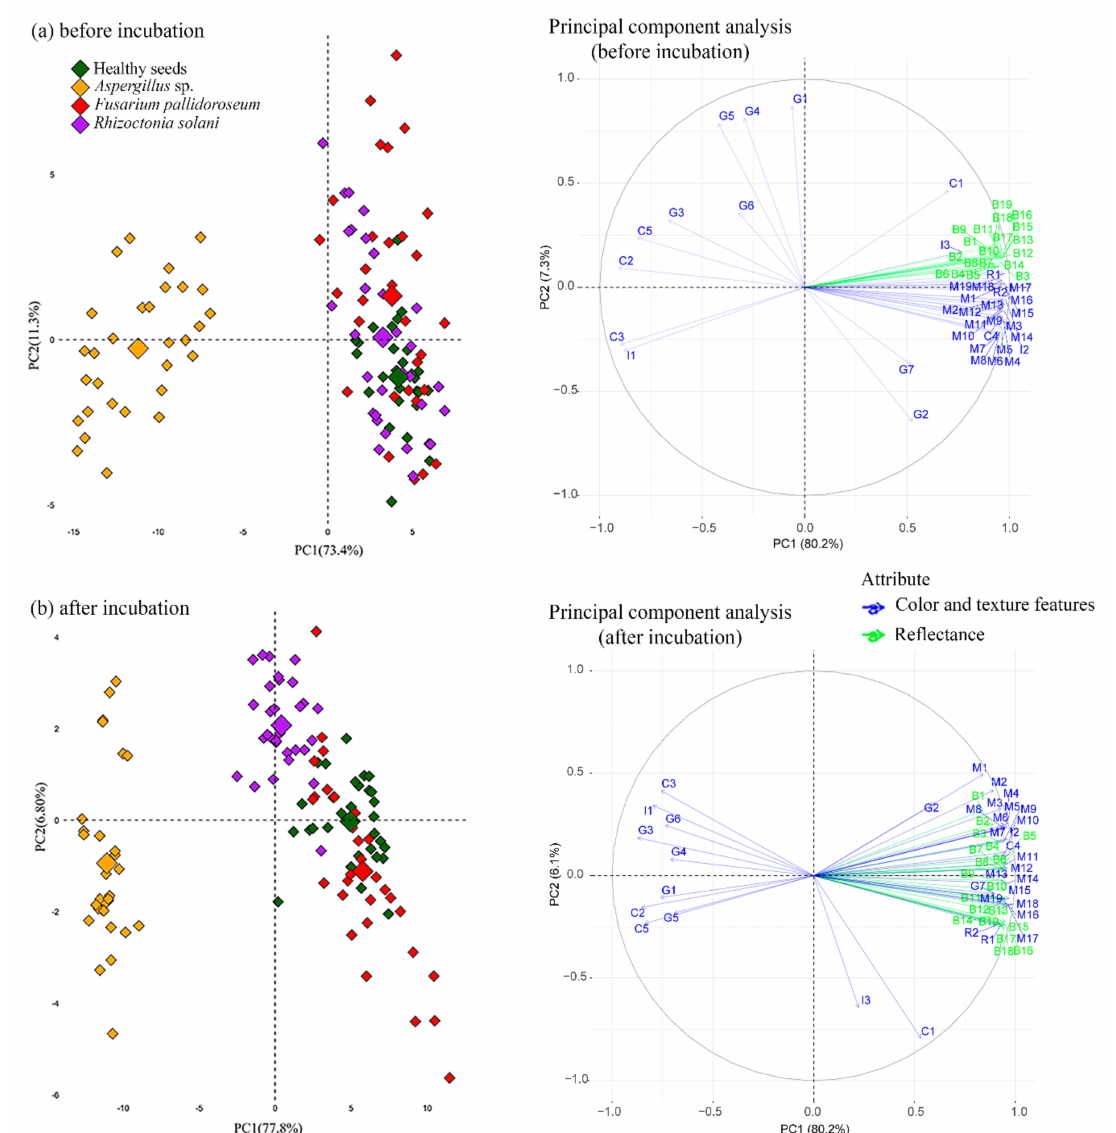
Figure 3. Biplots of principal component analysis for multispectral reflectance, color and texture features for classes of healthy seeds, Fusarium pallidoroseum, Rhizoctonia solani and Aspergillus sp. at 19 wavelengths (365 to 970 nm) before incubation ( a ) and after incubation ( b ). Attributes: Color and texture features – (R2): RegionMSIThresh; (R1):